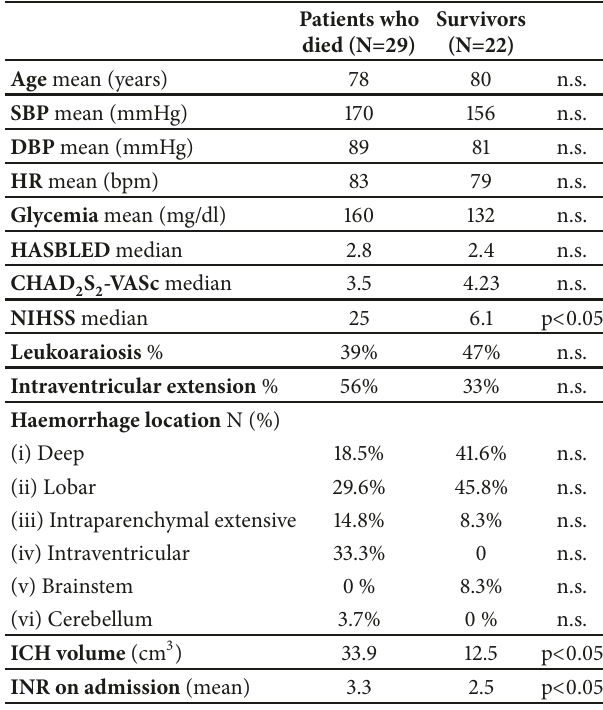
Table 4: Differences between patients who died and